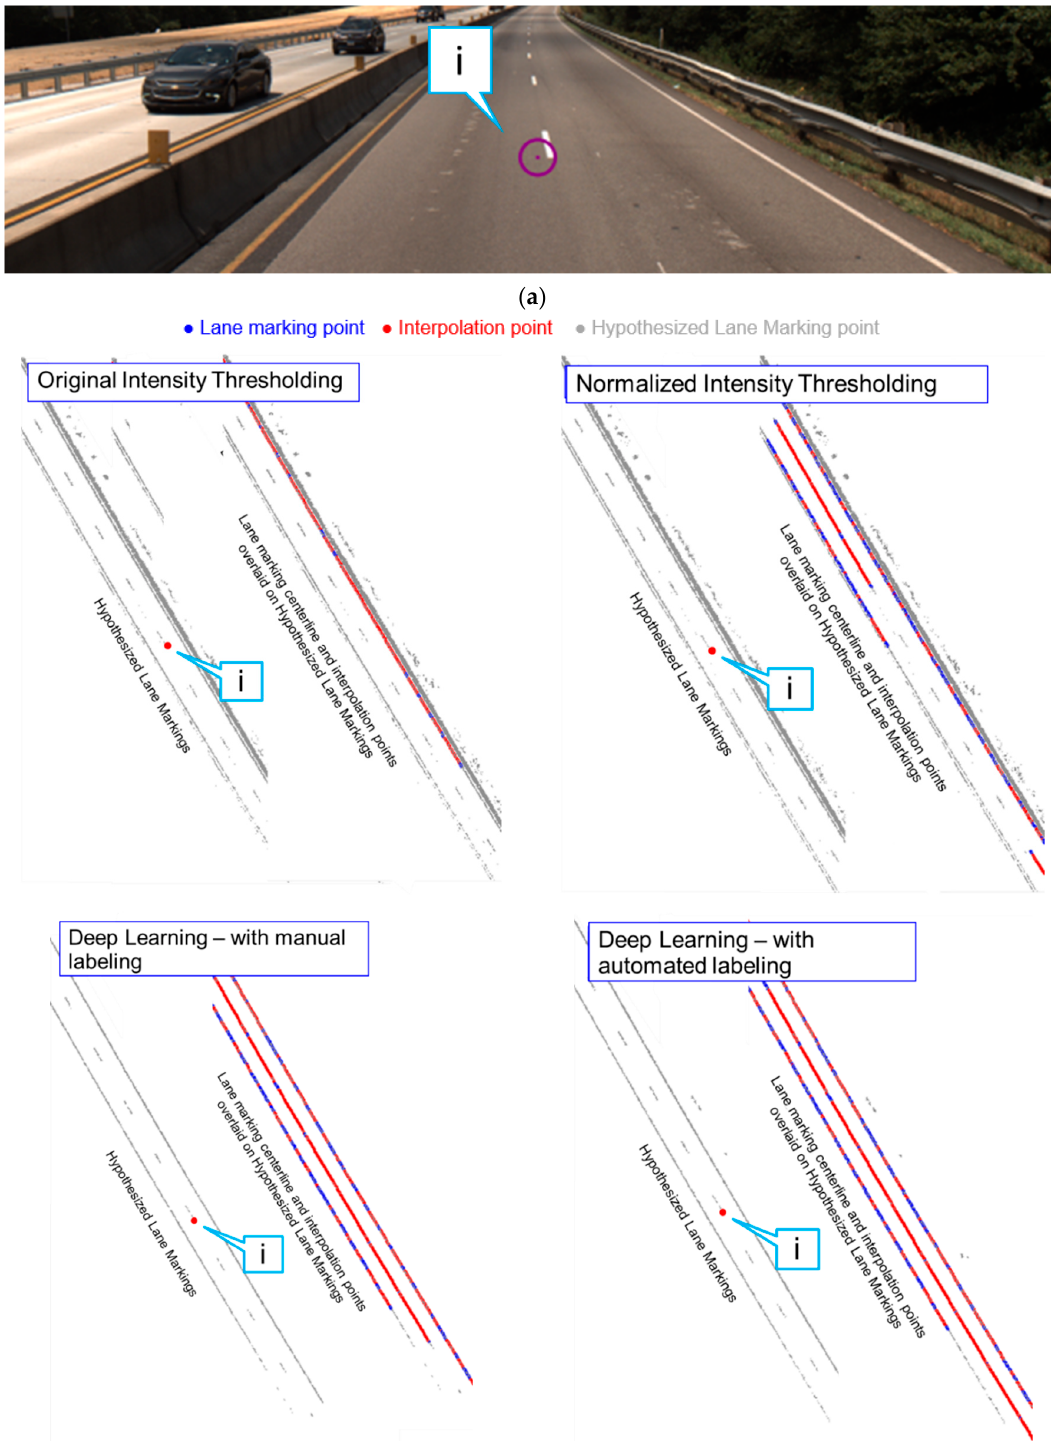
Figure 30. ( a ) RGB imagery and illustrations of ( b ) hypothesized lane markings (left), and lane marking centerline and interpolated points overlaid on the same hypothesized lane markings (right) in a poor lane marking area (red box in Figure 29) for dataset